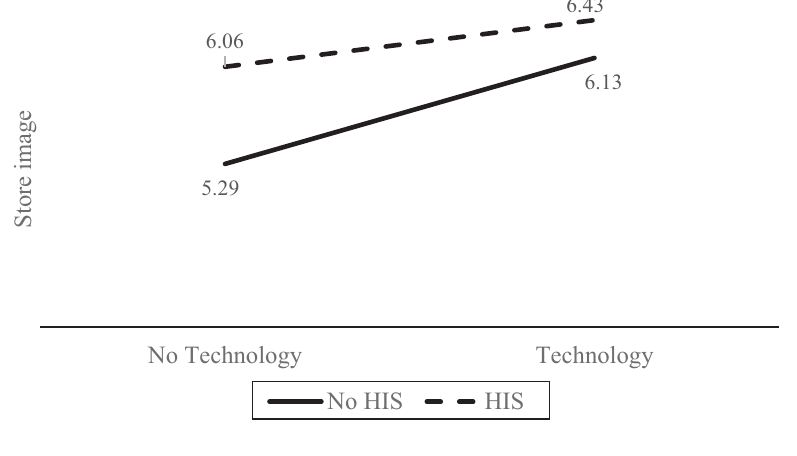
Figure 3. Effects of HIS